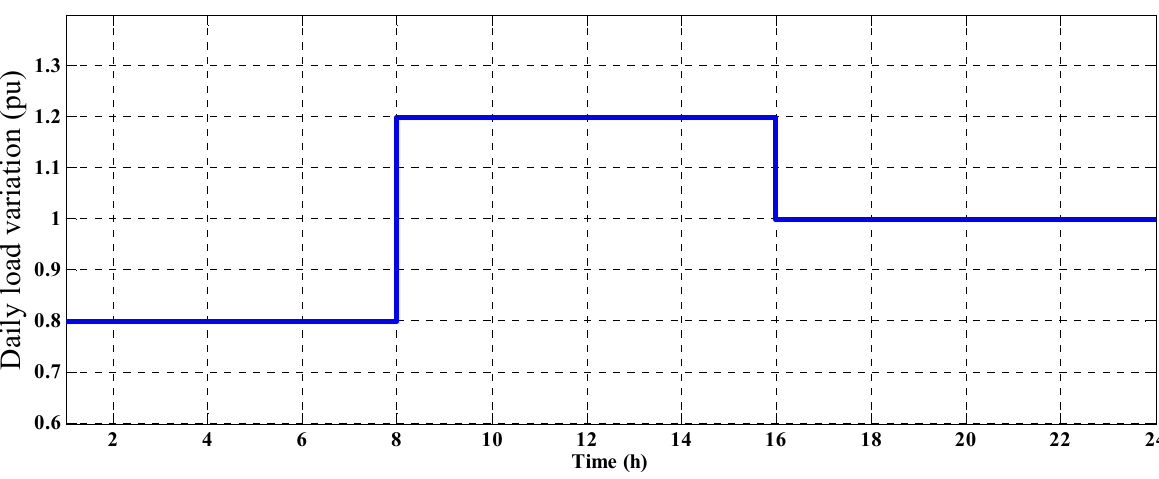
Figure 3. Daily load